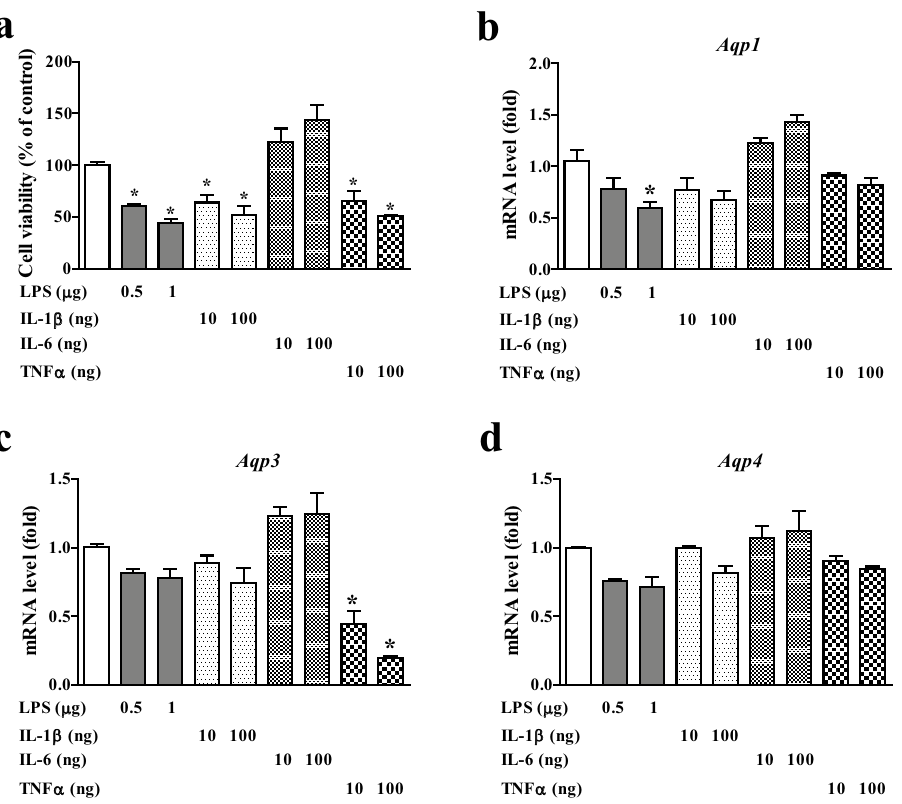
Figure 4. Aquaporin expression levels in chondrocytes by inflammatory cytokines. ( a ) Cell viability of chondrogenic C3H10T1/2 cells by pro-inflammatory molecules, lipopolysaccharides (LPS), interleukin 1 beta (IL-1β), IL-6 and tumor necrosis factor alpha (TNF-α). ( b – d ) mRNA expressions of AQP1 ( b ), -3 ( c ) and -4 ( d ) by LPS, IL-1β, IL-6 and